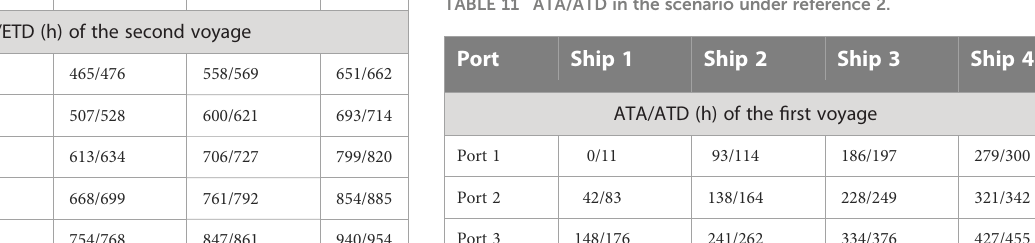
TABLE 11 ATA/ATD in the scenario under reference